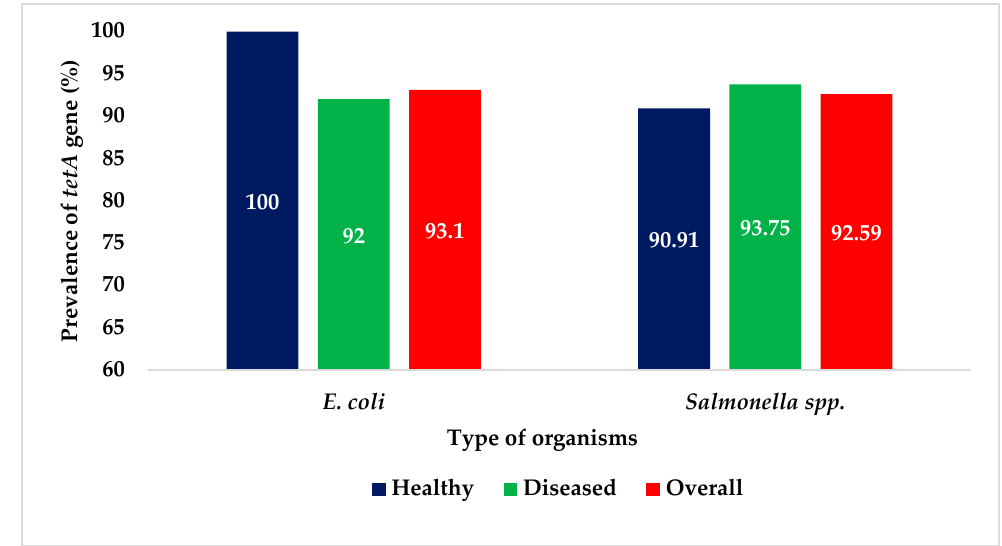
Figure 1. Prevalence of tetA gene in E. coli and Salmonella spp. isolated from turkeys.